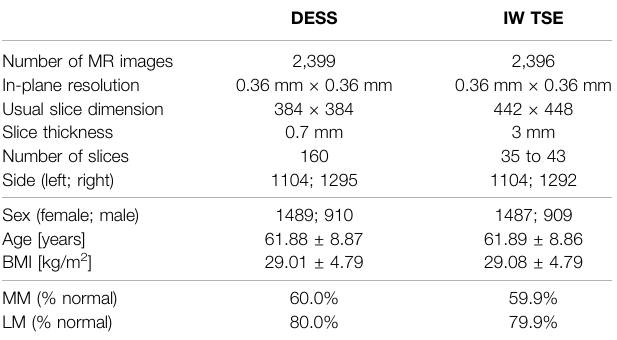
TABLE1| Demographics:Inthisstudy,2,399DESSand2,396IWTSEMRIscans from the OAI database are analyzed. In these data, slightly more normal than diseased medial menisci (MM) and lateral menisci (LM) are contained. Here, normal is de fi ned as no conspicuous features with respect to the MOAKS scoring system in any